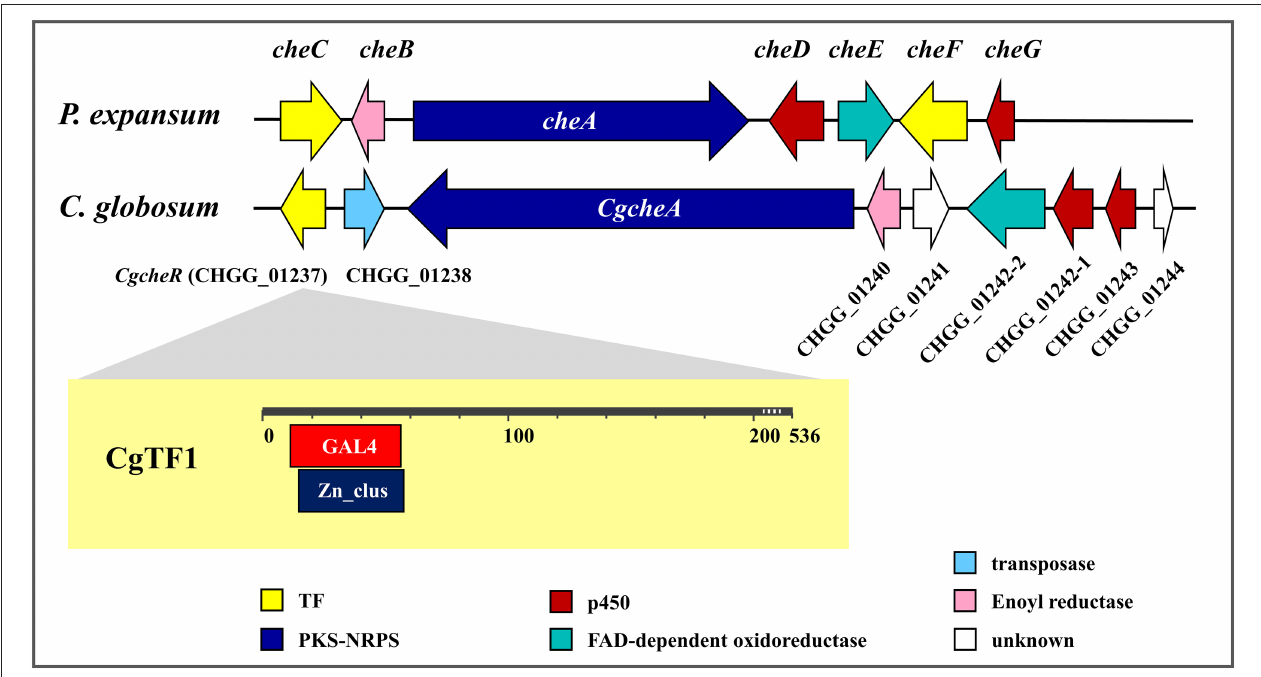
FIGURE 1 | Chaetoglobosin A biosynthetic gene clusters in Penicillium expansum and Chaetomium globosum . of gene Cgtf1 . For further confirmation, genomic DNA was extracted, digested and subjected to Southern blot analysis as previously described (Hu et al., 2018). A 695 bp 3 ′ -flank of Cgtf1 and a 2,124 bp Hyg R fragment were labeled as